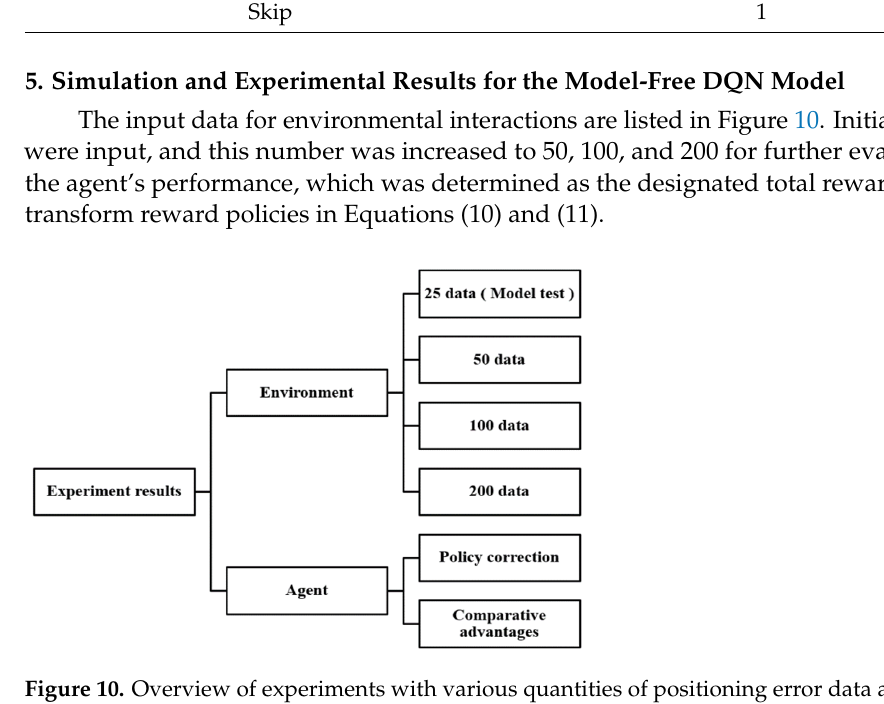
Table 3. Parameters of the DQN.